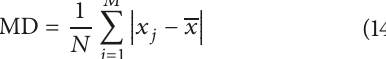
are made best use in this case. Although the distributions of the mild and the conserved are similar, the mild present a better balance than the conserved. Actually, the MD values of the conserved are the biggest in the both scenarios and they are not conducive to make full utilization of